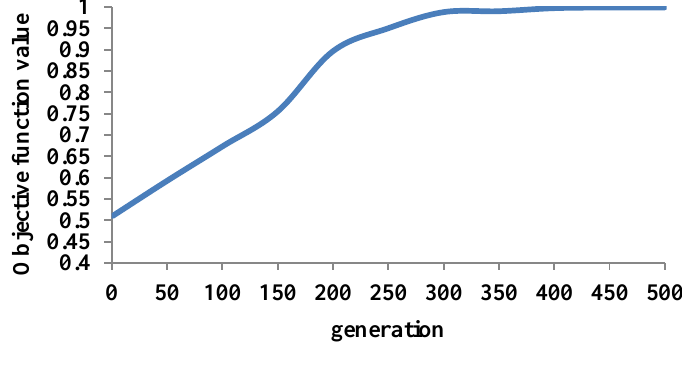
Fig. 5. Objective function value convergence